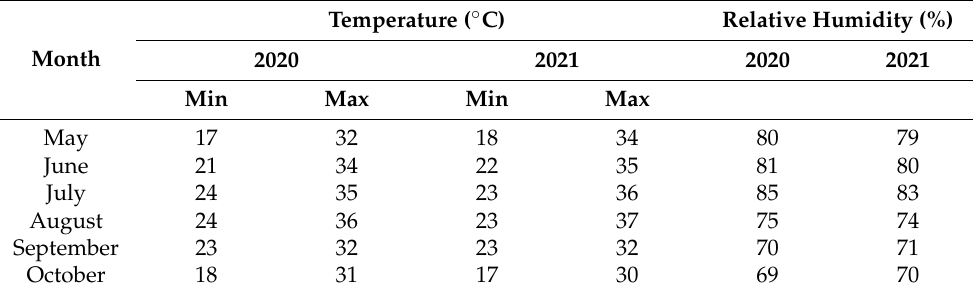
Table 3. The weather conditions during the 2020 and 2021 growing seasons. Temperature ( ◦